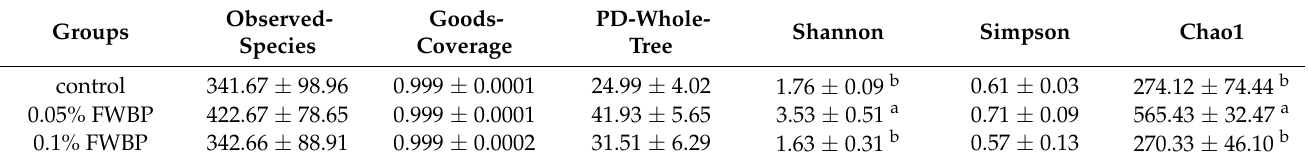
Table 2. The effects of FWBP on α -diversity in the gut.